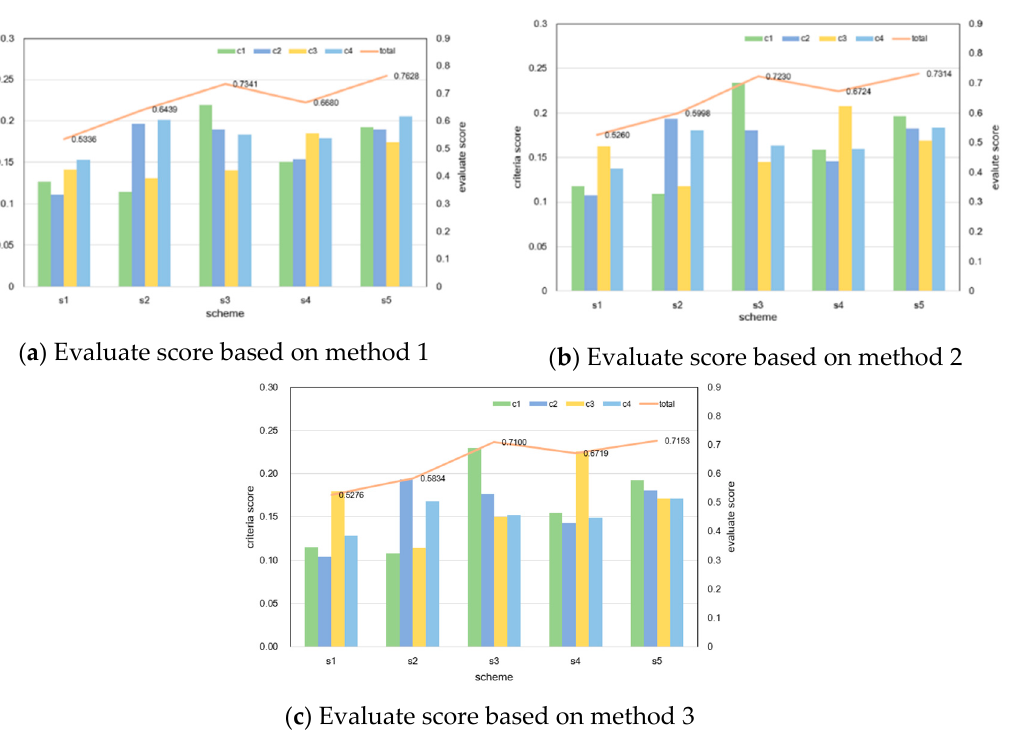
Figure 7. Evaluate scores based on different methods.